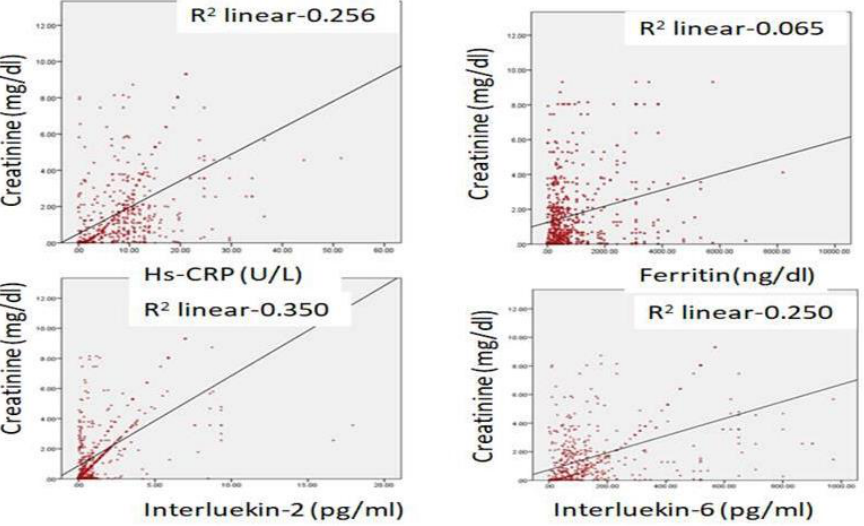
Figure 6. Regression analysis between admission creatinine levels and admission Hs-CRP, ferritin, IL-2 and IL-6 levels.